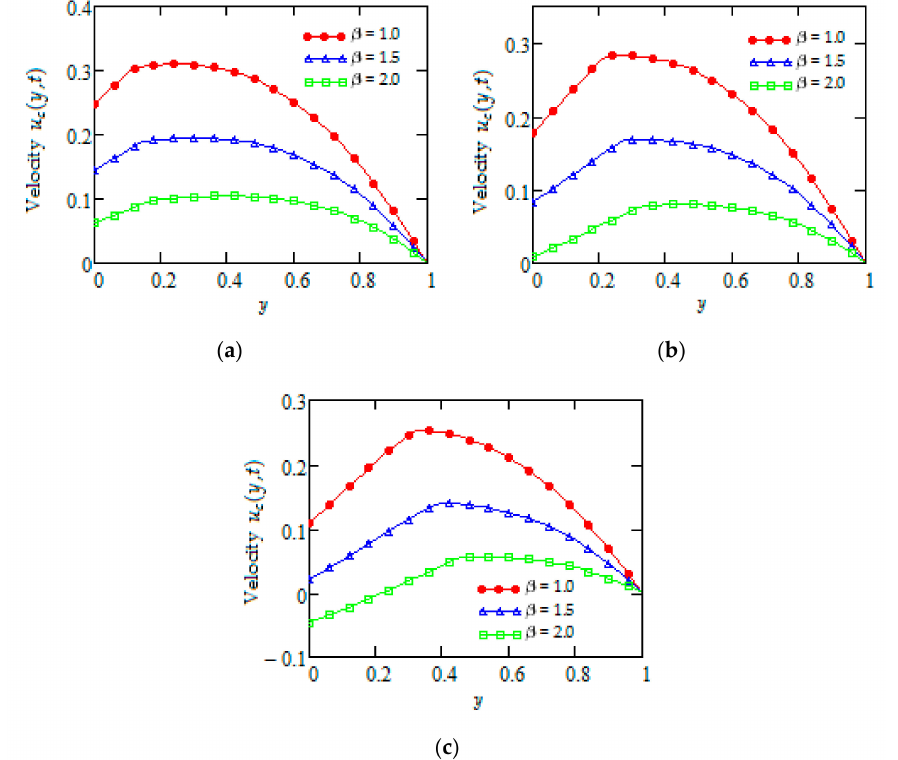
Figure 1. The profiles of velocity u c ( y , t ) for We = 0.5 and different values of the pressure–viscosity parameter β at ( a ) t = 0.05, ( b ) t = 0.10, ( c ) t =